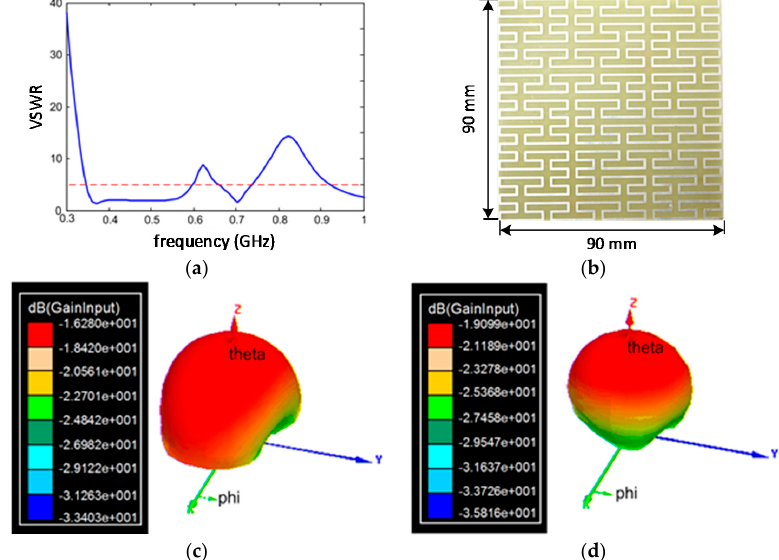
Figure 3. The third Peano fractal antenna: ( a ) Voltage standing wave ratio (VSWR) curve of the third Peano fractal antenna; ( b ) the prototype of the third Peano fractal antenna; ( c ) the 3 ‐ D radiation patterns of the third Peano fractal antenna at 370 MHz; and ( d ) the 3 ‐ D radiation patterns of the third Peano fractal antenna at 700 MHz.